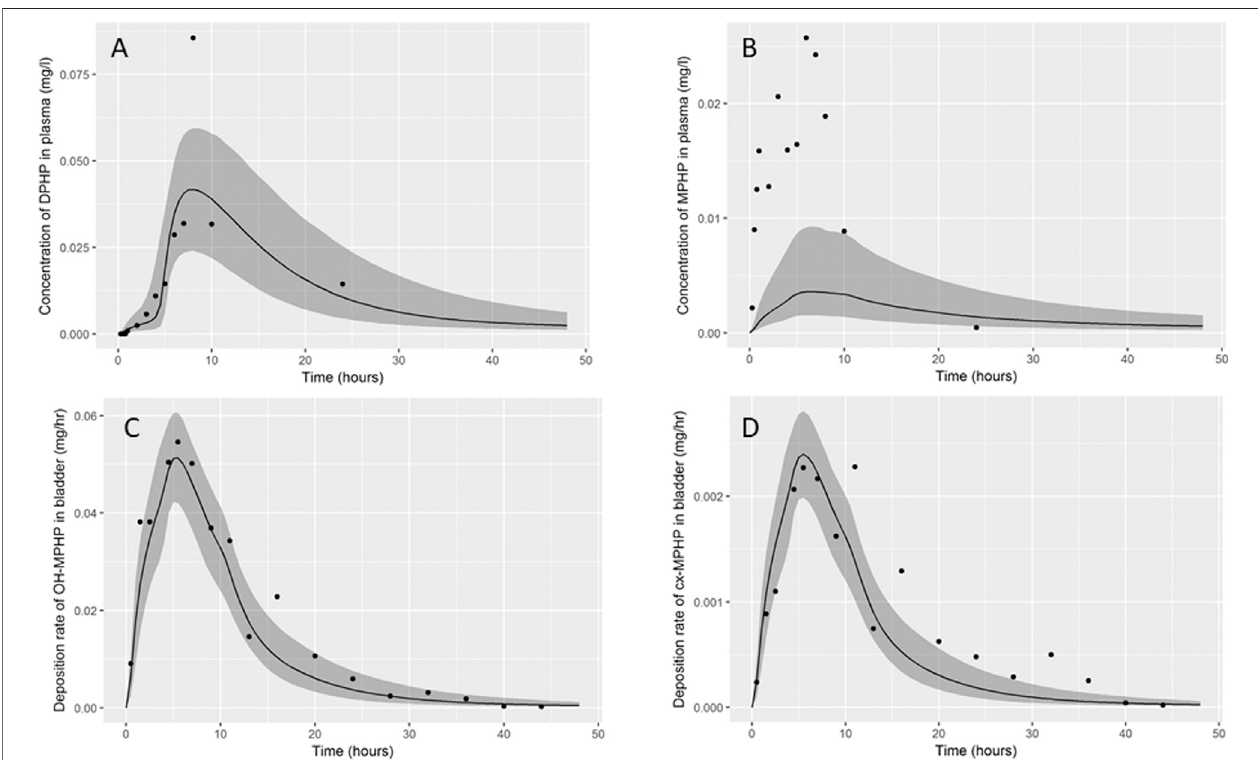
FIGURE 7 | Fit of the calibrated model to data (A) blood DPHP, (B) blood MPHP and urinary excretion of (C) OH-MPHP and (D) cx-MPHP for volunteer C using global (non-volunteer speci fi c) and local (volunteer speci fi c) parameters provided in Table 3 and Table 4 . The central estimates indicated in plots correspond to the posterior mode whereas the shaded regions represent 95% intervals for the respective